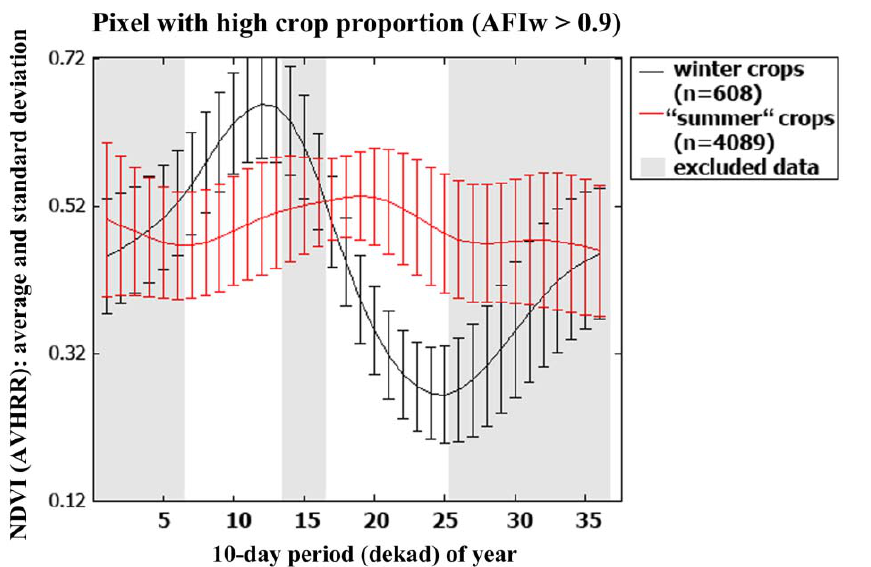
Figure 3. NDVI profiles of winter crops (in black) and the remaining crop land (labeled “summer” crops) (in red) in Tuscany derived from pixels with a high proportion of arable land (CORINE). The white areas highlight the dekads (ten-day periods) used for modeling (7–13 and